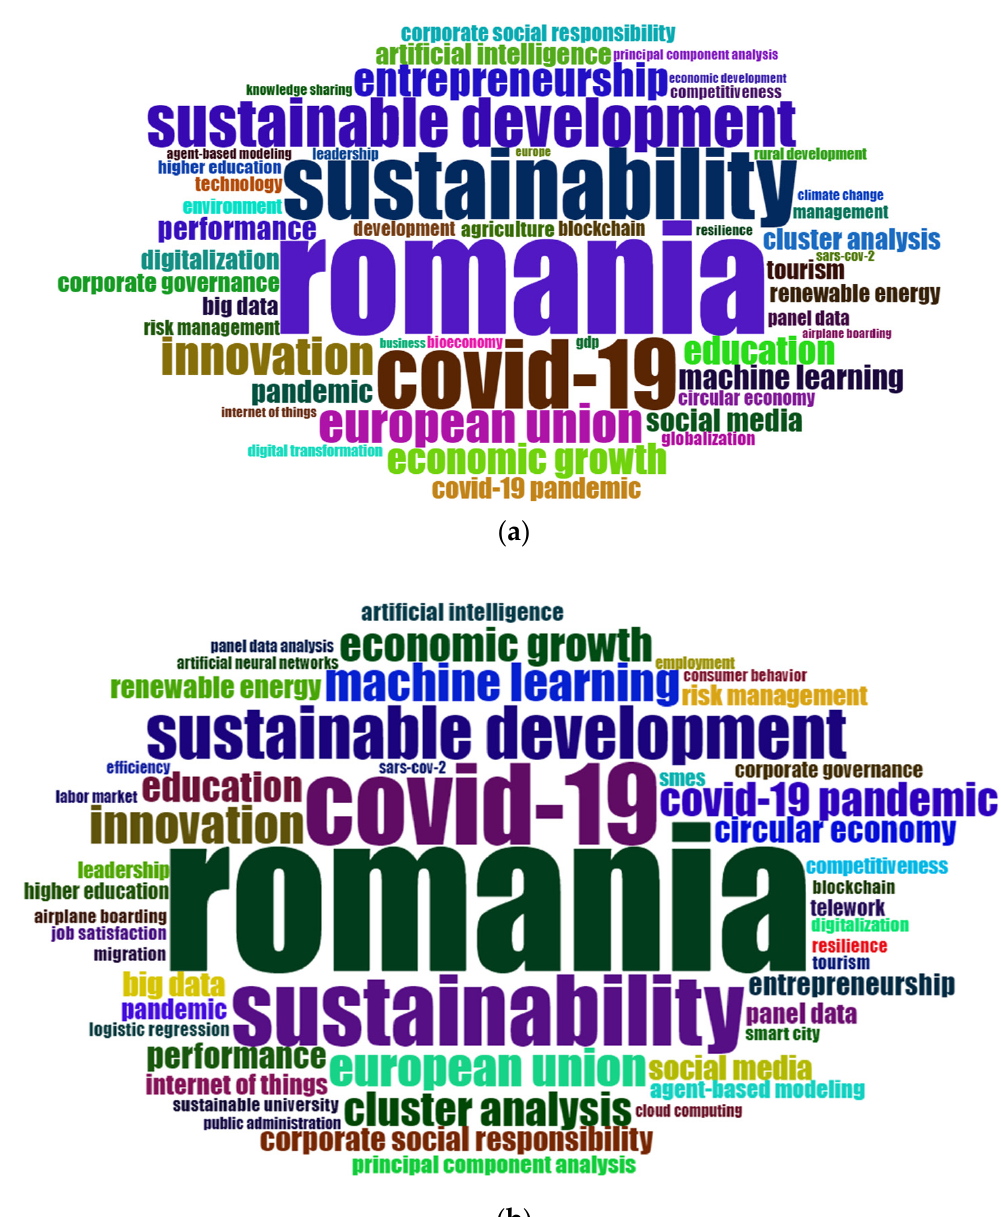
Figure 8. Most frequent keywords in abstracts of publications. ( a ) WoS. ( b ) Scopus.